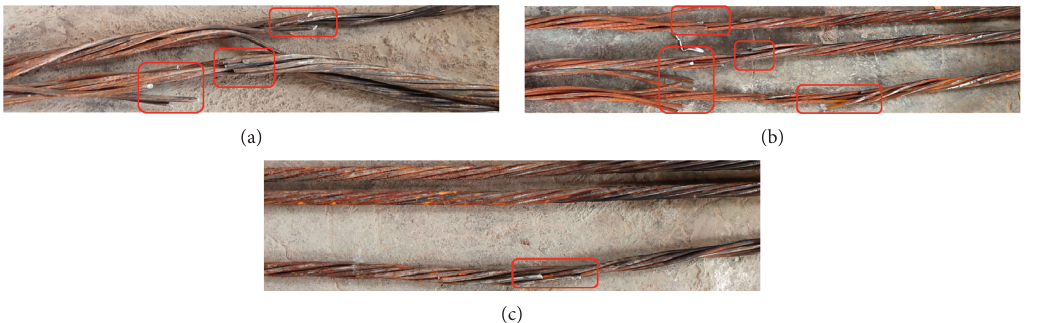
Figure 9: Fracture in prestressing strands. (a) SP-A. (b) SP-B. (c) SP-C.